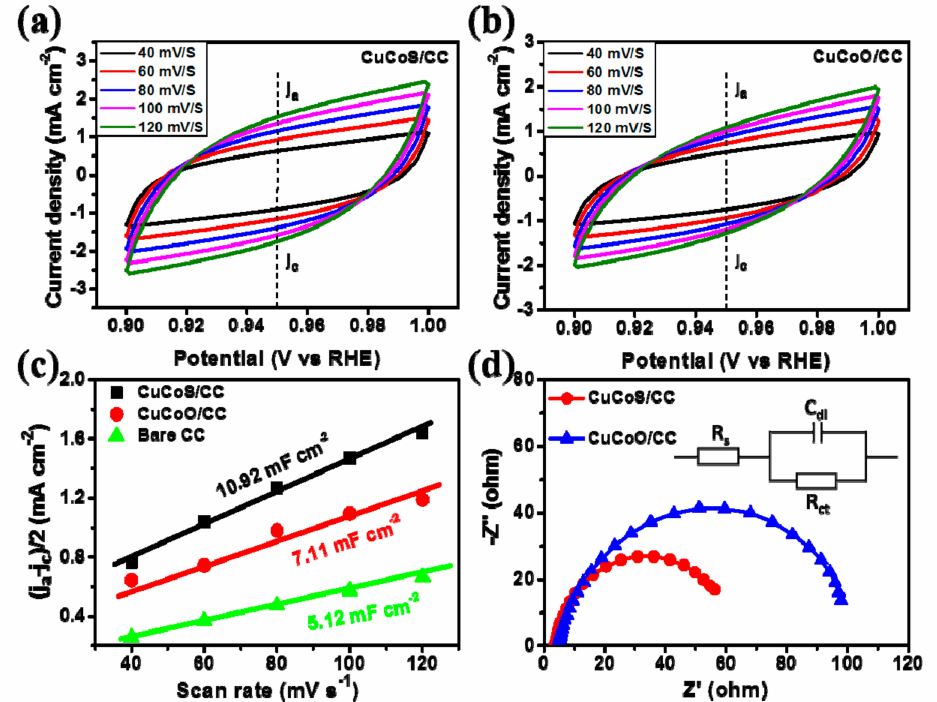
Figure 4. Cyclic voltammetry of ( a ) CuCoS / CC and ( b ) CuCoO / CC. ( c ) electrochemical surface areas of CuCoS / CC, CuCoO / CC and bare CC. ( d ) Electrochemical impedance spectroscopy plots for CuCoO / CC and CuCoS /